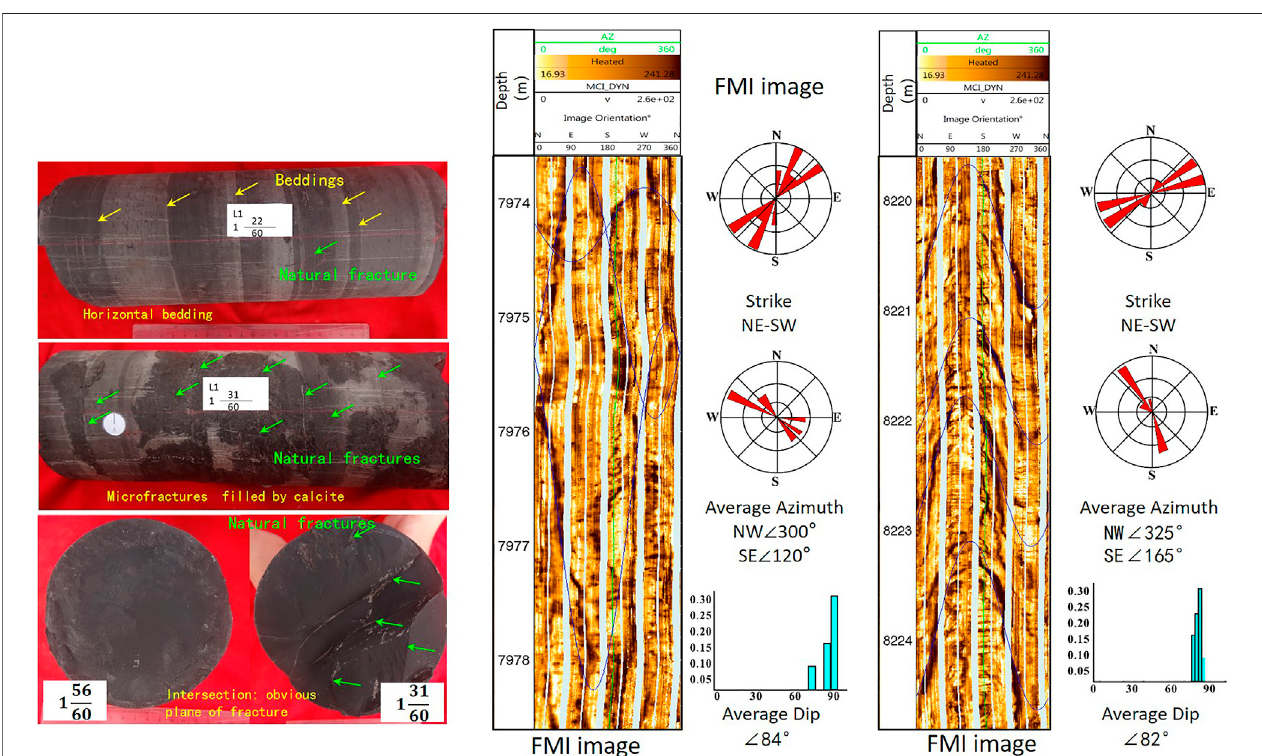
FIGURE 3 | Cores, imaging logging photos, and natural fracture orientations in Well L1. This fi gure contains three parts, the left are core pictures from 8,641 – 8,649.5 m of well L1, Є 1y formation, and the source rock. The right parts are the FMI image and natural fractures picked up from FMI logging in 7,904~8044 m and 8,195~8,260.5 m,